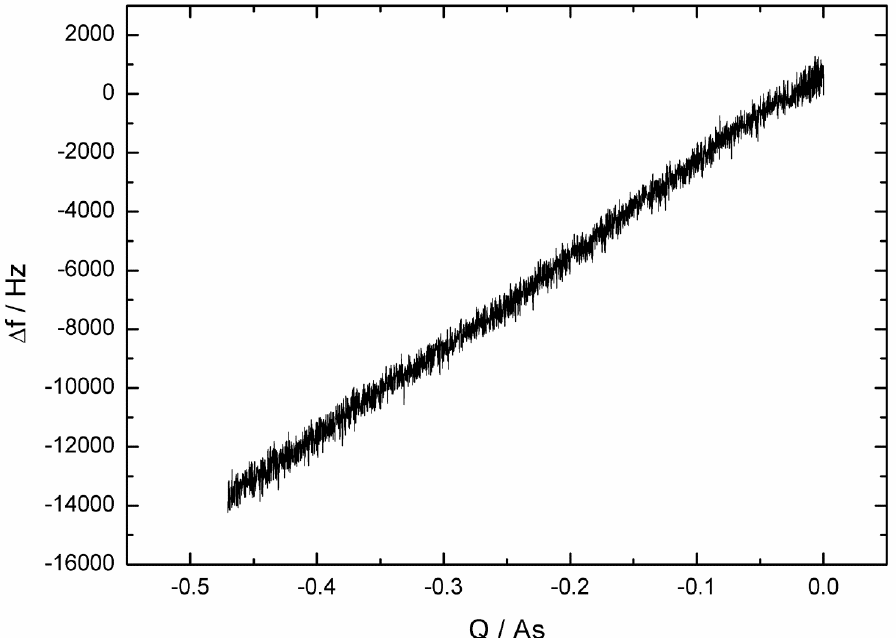
Figure 16. Calibration measurement. Change of the resonance frequency ∆ f as received from the chronopotentiometric experiment plotted against charge